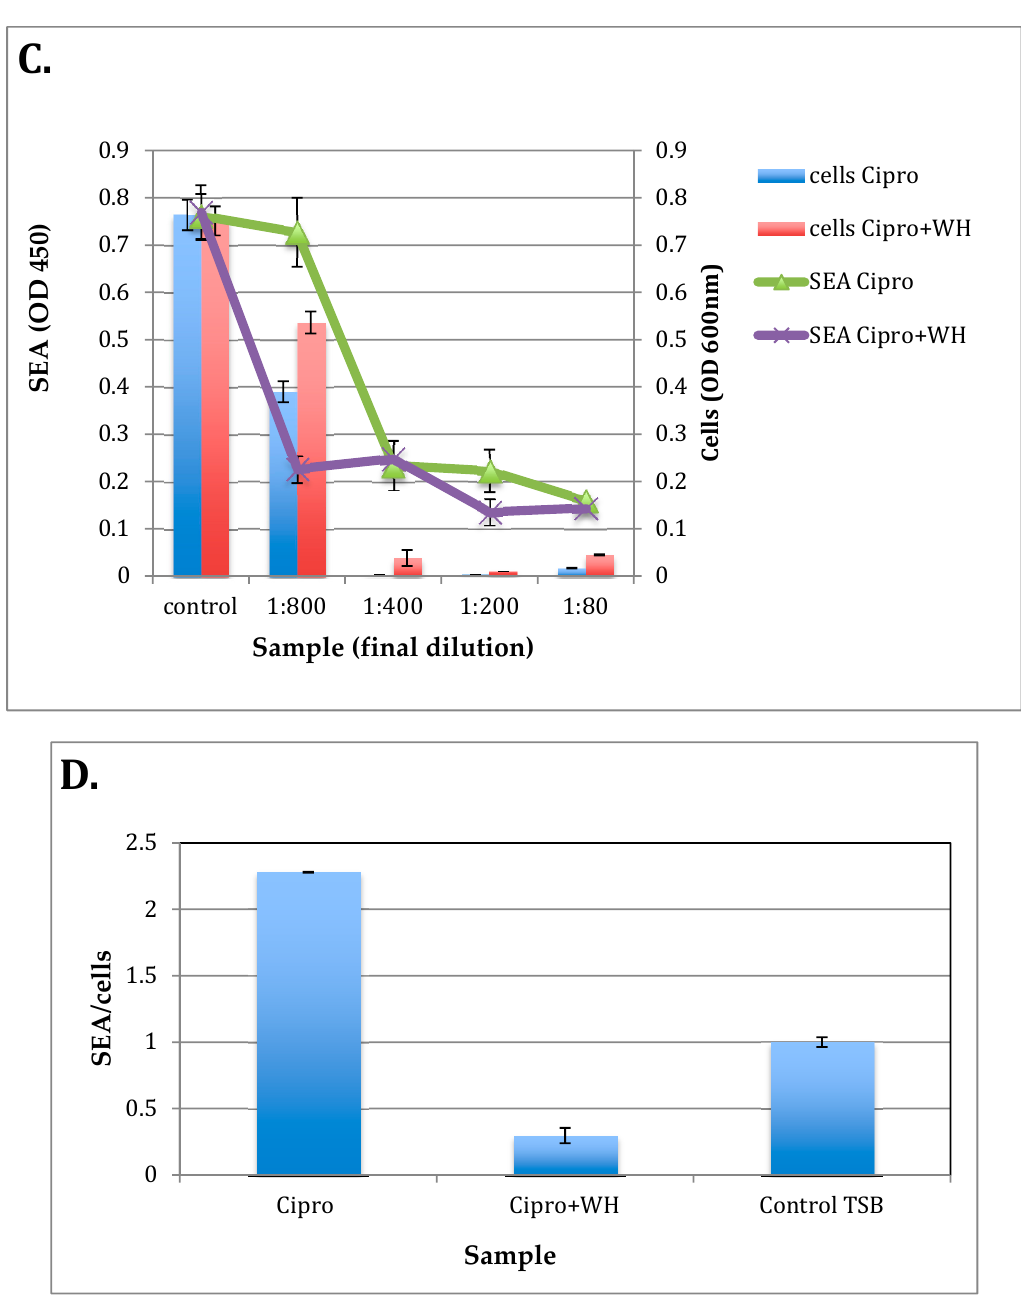
Figure 3. The effect of ciprofloxacin (Cipro) +/ − whISOBAX (WH) on S. epidermidis growth and biofilm formation ( A , B ) and on S. aureus growth and toxin production ( C , D ). Control cells were grown without test solution. S. epidermidis were grown overnight at 37 °C with increasing concentrations of Cipro and/or WH, and cell density determined ( A ). Unbound cells were removed, and biofilm was stained and OD determined ( B ). S. aureus were grown with increasing concentrations of Cipro and/or WH, and cell density determined ( C ). Supernatants were collected, and the presence of Staphylococcal enterotoxin A (SEA) was tested by ELISA ( C ). The ration between SEA and cell density when S. aureus were grown in subinhibitory concentrations of Cipro is shown in ( D ), which correspond to Cipro diluted 1/800, i.e., ½ its MIC levels.